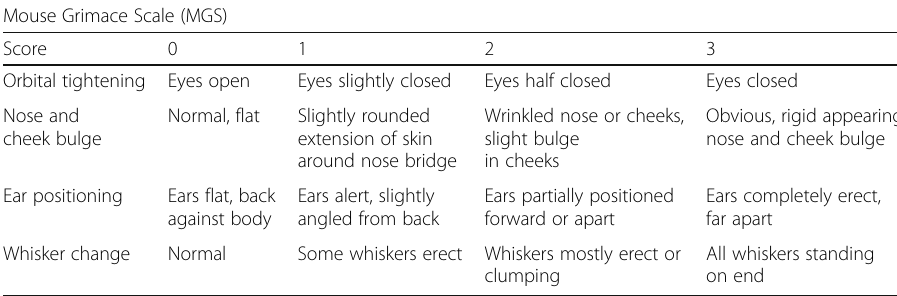
Table 3 Modified MGS scoring system for monitoring of surrogate endpoints and assessment of disease severity in mouse CLP sepsis, adapted from Langford et al.